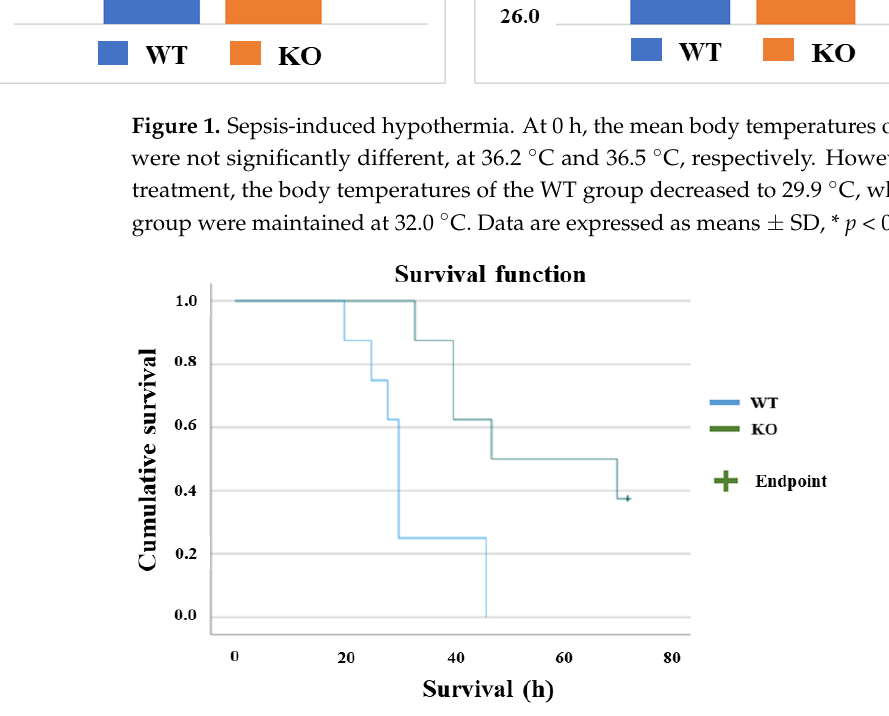
Figure 2. Survival plot. The survival rates were compared between the two groups ( n = 10 per group) with log-rank test, and a significant difference was observed ( p = 0.004). In the WT group, half of the mice died within 30 h after CLP treatment, and all died within 46 h. In the KO group, more than half of the animals survived for 70 h or longer. 2.2. Effects of Cyclophilin D KO on Neuronal Cell Death Celestine blue and acid fuchsin staining was performed to analyze neuronal cell death in both the parietal cortex and hippocampus (including the CA1, CA2, and CA3 regions) 18 h after the CLP treatment (Figure 3A,B). Neuronal damage (densely stained cells with a high nuclear/cytoplasmic ratio, cellular swelling, as well as neuronal vacuoli- zation) in the cerebral cortex and the hippocampus was counted and displayed as the percentage of damaged neurons (of total number of cells) (Figure 3C,D). At 0 h after the CLP treatment, there was no significant difference between the two groups regarding nei- ther the cerebral cortex nor the hippocampus. At 18 h, neuronal cell death was signifi- cantly more severe in both the cerebral cortex and hippocampus in the WT group as com- pared to the KO group (cortex: p < 0.001, hippocampus: p = 0.004). Specifically, in the cer- ebral cortex, necrotic cells in the WT group were increased from 3.79% to 63.8% from 0 h to 18 h, while those in the KO group changed from 3.45% to 10.1% from 0 h to 18 h. In the hippocampus, necrotic cells in the WT group increased from 4.29% to 10.5% from 0 h to 18 h, while those in the KO group changed from 3.53% to 4.65% from 0 h to 18 h. In both groups, signs of cerebral edema-like changes were observed following CLP, and the brain was damaged, but when comparing the number of necrotic cells, the WT group was more seriously damaged (Figure 3).